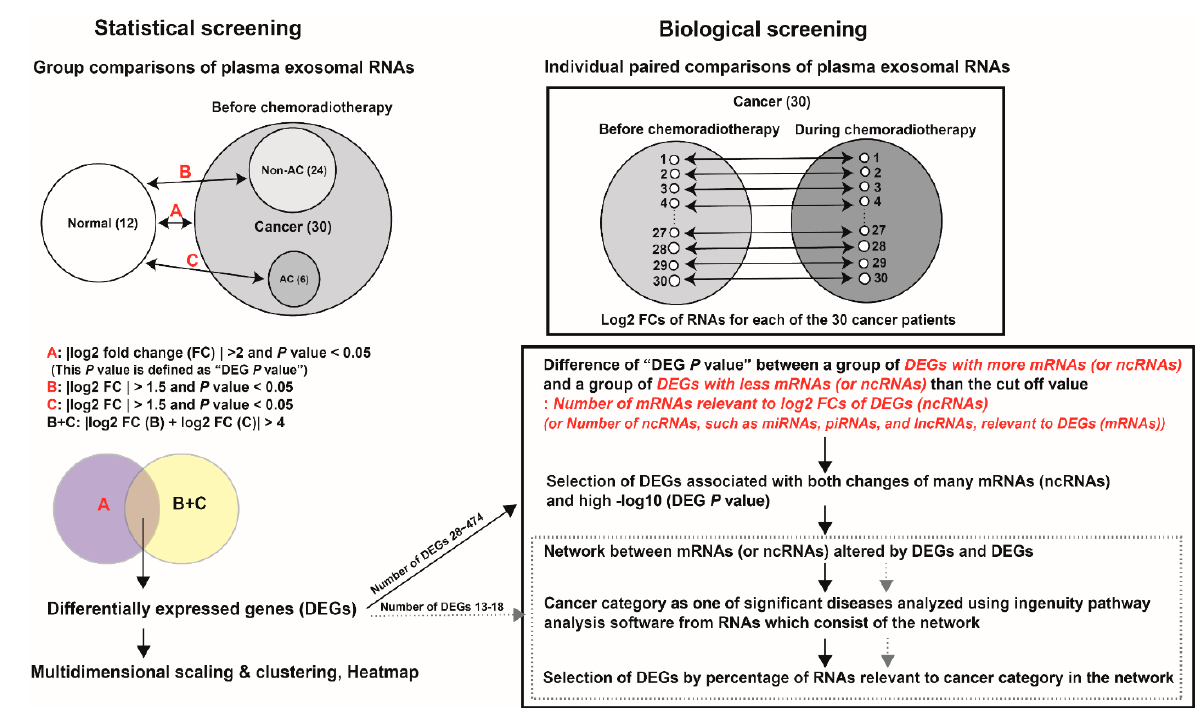
Figure 1. A plasma exosomal RNA screening method for cancer diagnosis that consists of a statistical screening phase followed by a biological screening phase.